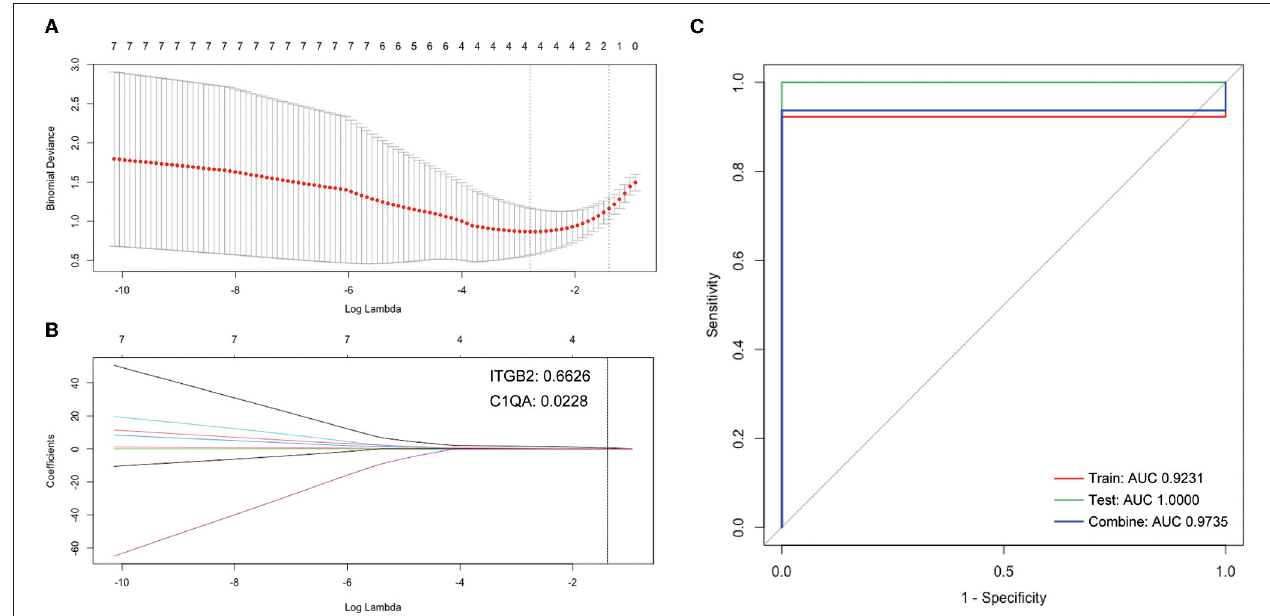
FIGURE 5 | Construction of LASSO cox regression model. (A) The red dots represent the values of binomial deviance; the gray lines represent the standard error (SE); the vertical dotted lines represent optimal values by the minimum criteria and 1-SE criteria. “Lambda” represents the tuning parameter. (B) The plot determines the coefficient by 1-SE criteria of LASSO regression model 0.0228 and 0.6626 for C1QA and ITGB2 , respectively. (C) The ROC curves of the LASSO regression model of training, testing, and combination cohort in